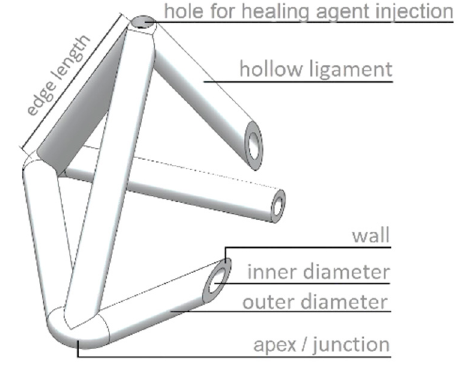
Figure 1. Schematic diagram of a generic MVN unit, main components.